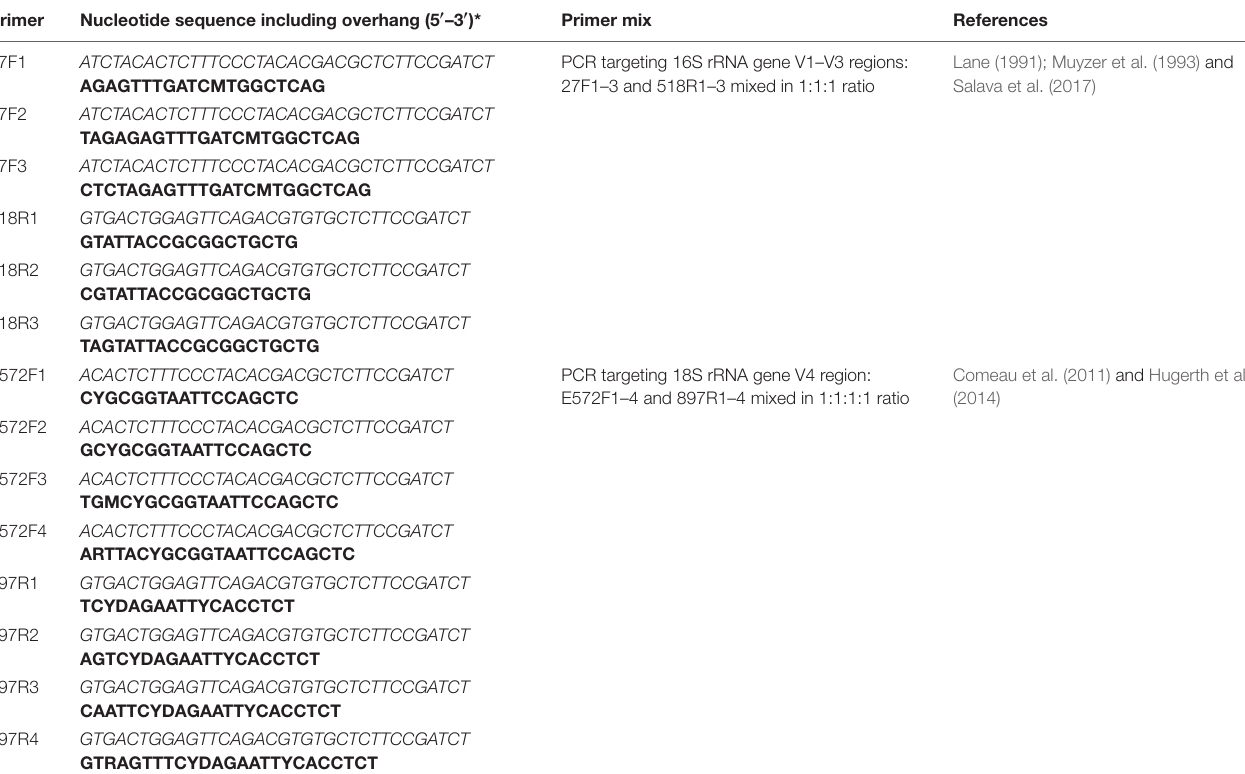
TABLE 1 | Primers and primer mixes used for the PCR amplification of 16S rRNA and 18S rRNA genes from DNA extracted from sediments collected from the Archipelago Sea (Baltic Sea). Primer Nucleotide sequence including overhang (5 (cid:48) –3 (cid:48) )*